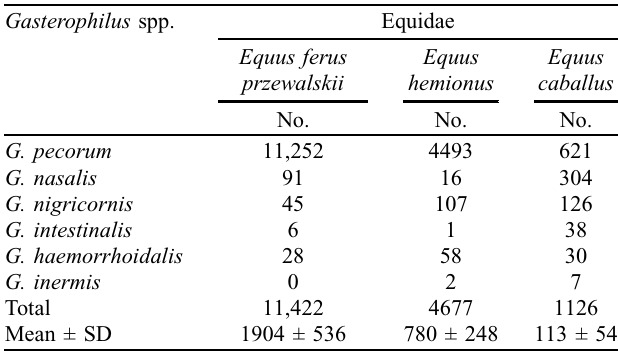
Table 1. Prevalence of Gasterophilus spp. larvae in three equids in Kalamaili Nature Reserve, China. Gasterophilus